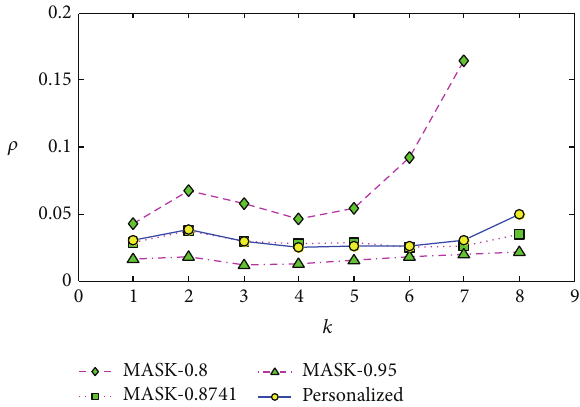
Figure 10: Support error 𝜌 versus minimum support on different size of datasets.